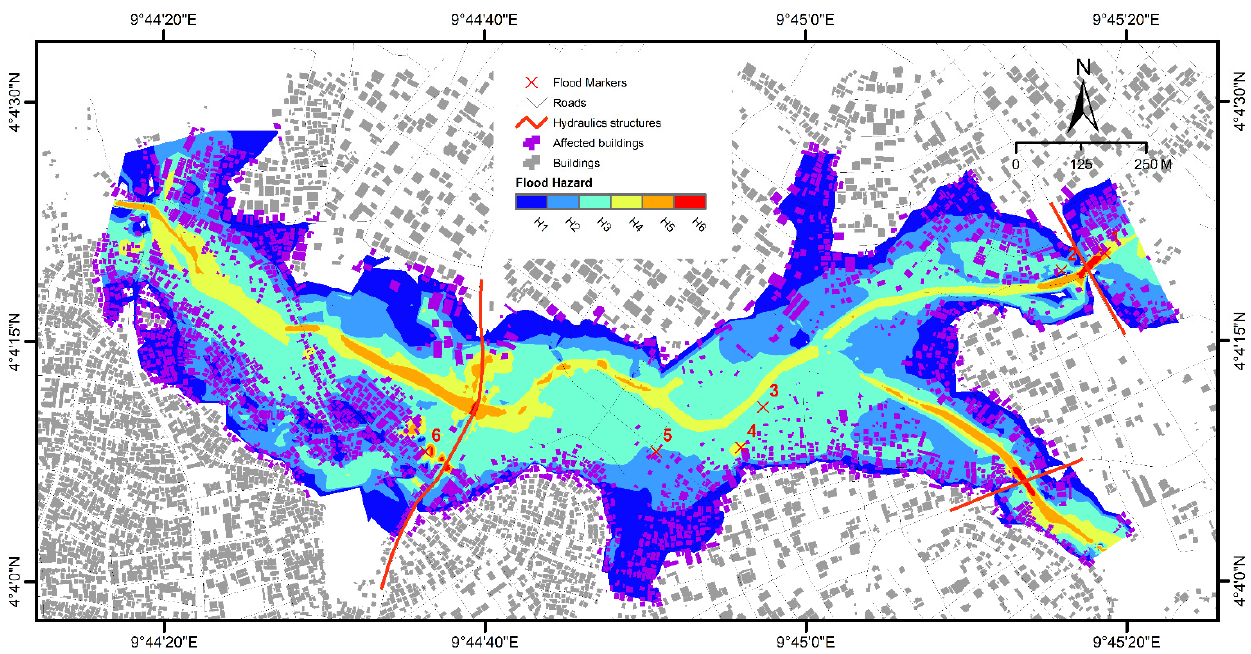
Figure 9. Flood hazard classification according to the AIDR criteria [87].